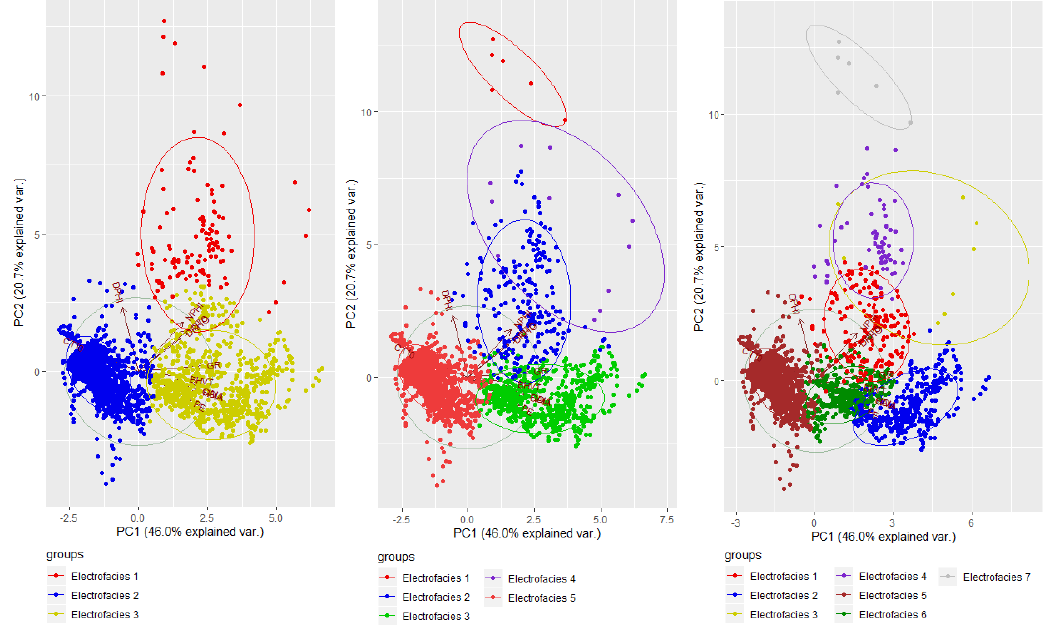
Figure 2. Three, 5 and 7 clusters identified by employing Principal Component Aanalysis using principal component 1 and principal component